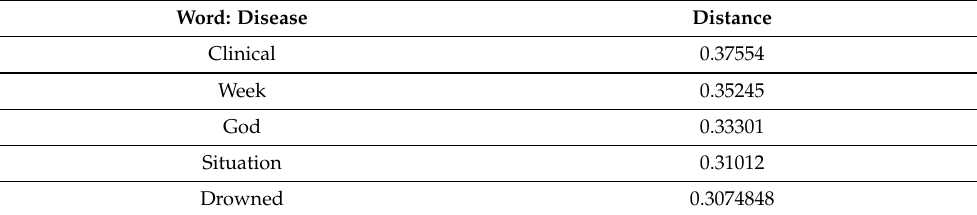
Table 5. Closest words to